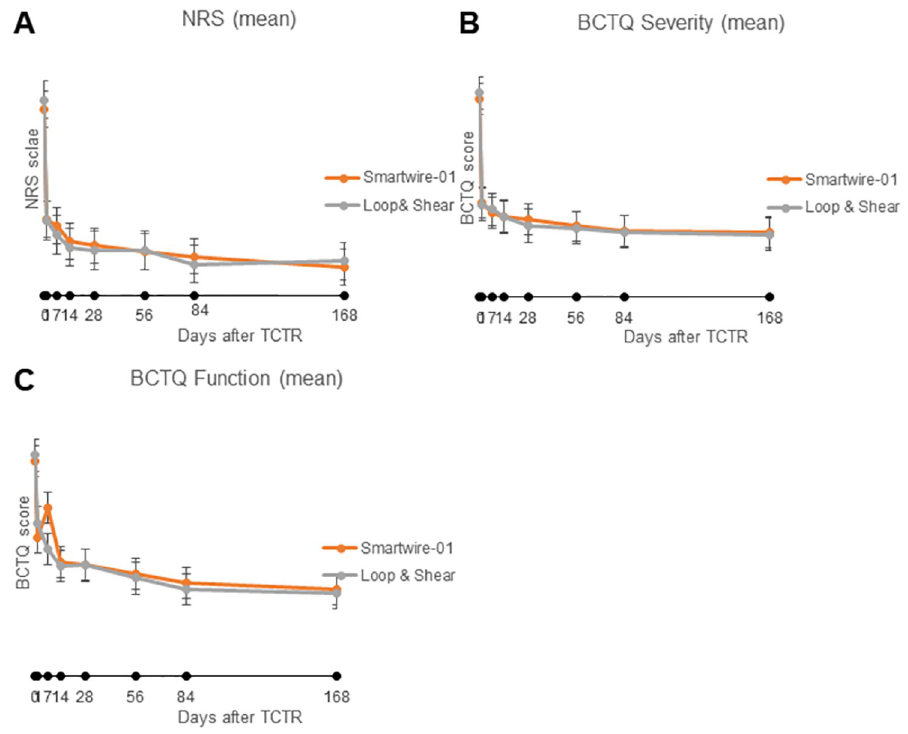
Fig 4. Post-TCTR time-dependent changes of pain and function of patients in the two threads (primary outcomes). A: NRS scale. B: BCTQ functional scale. C: BCTQ severity scale.